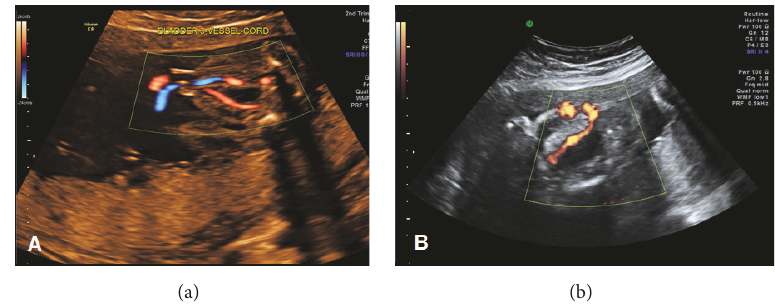
Figure 1: Cross-sectional images of the fetal pelvis: (a) at 20 weeks of gestation showing with color Doppler the two umbilical arteries around the fetal bladder and (b) at 29 weeks of gestation with only one umbilical artery.